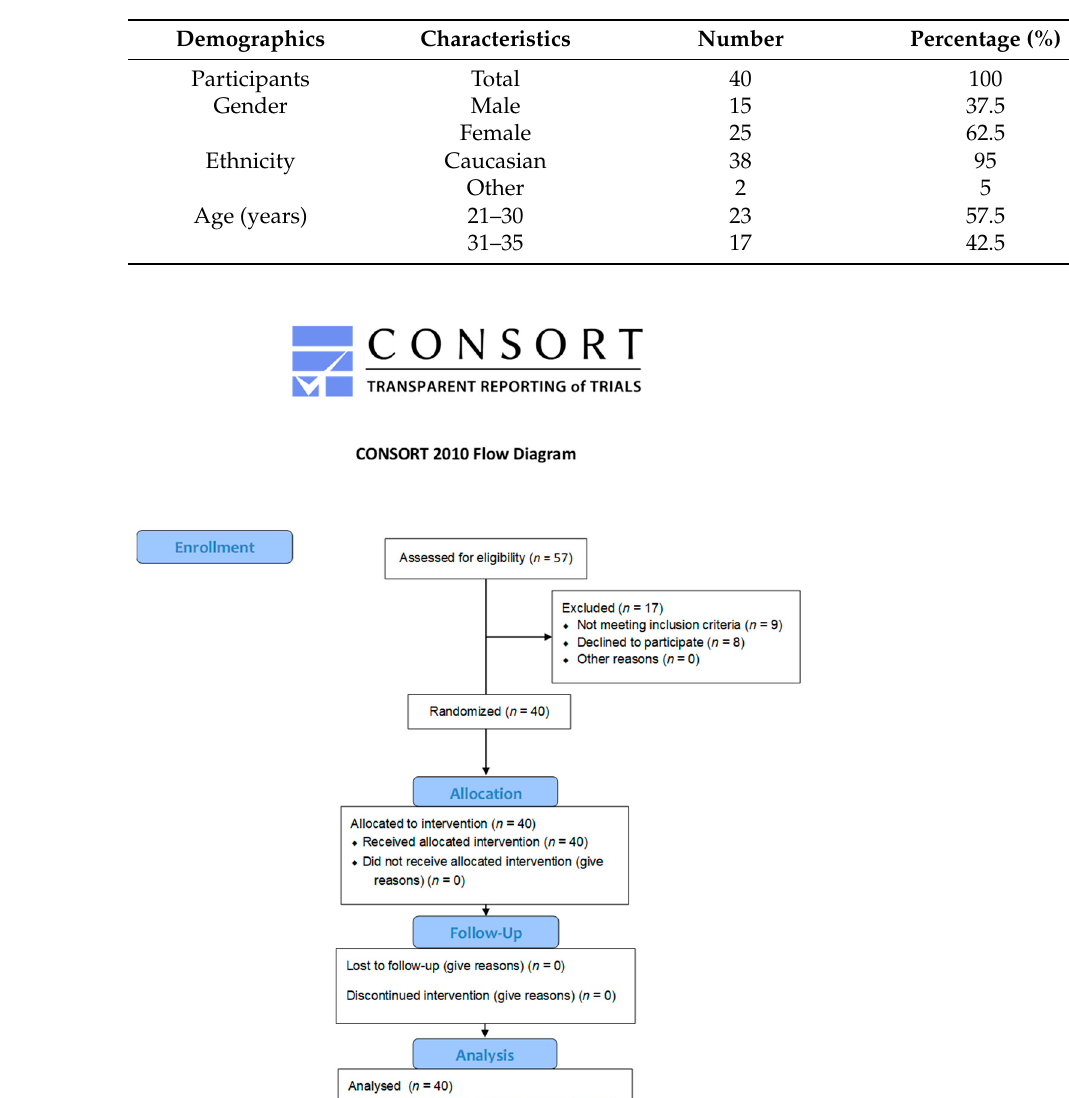
Table 1. Demographic data. Demographic information for 40 healthy volunteers.